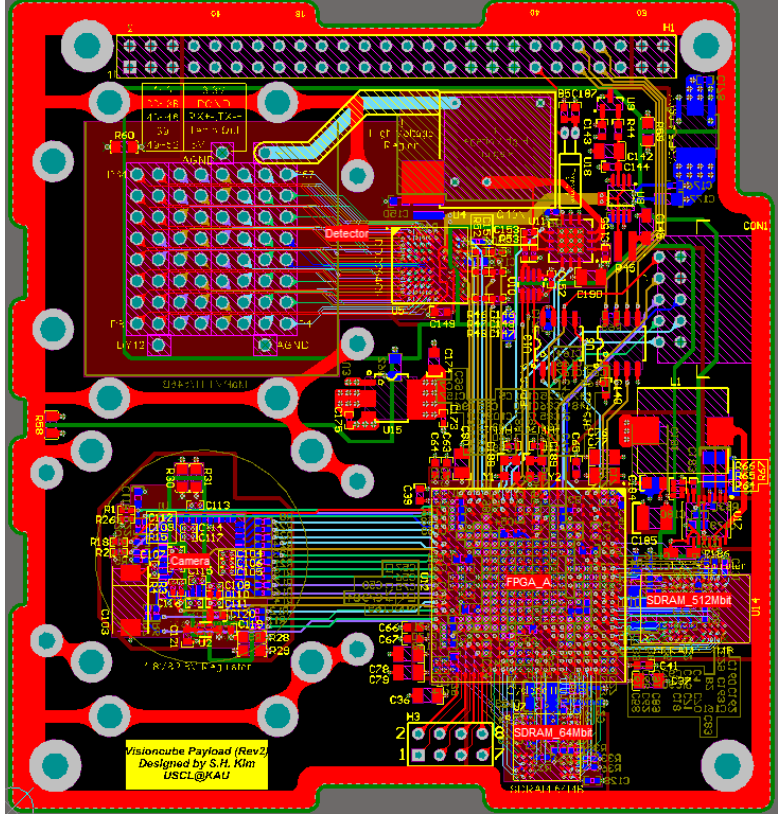
Figure 5. Design of PCB artwork of the TLE observation